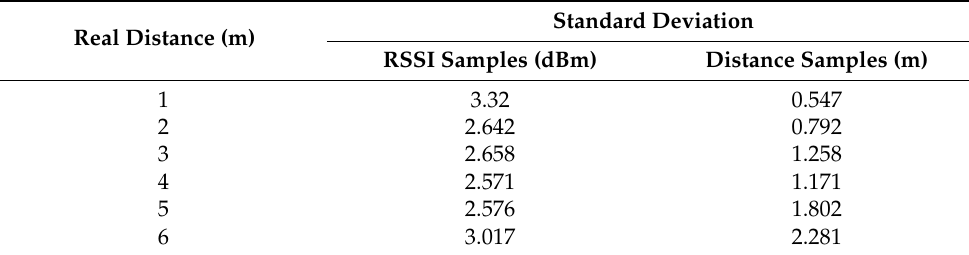
Table 1. The standard deviation of the collected RSSI samples and their equivalent distances. Standard Deviation Real Distance (m) RSSI Samples